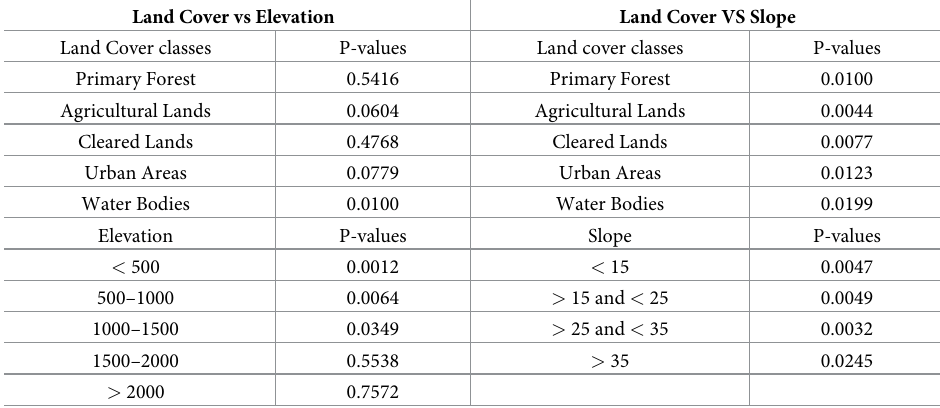
Table 11. Non-parametric ANOVA test of LST significance on